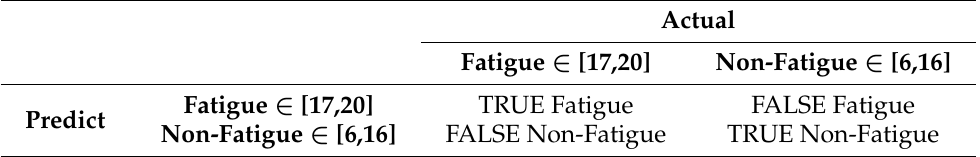
Table 3. Fatigue detection confusion matrix.